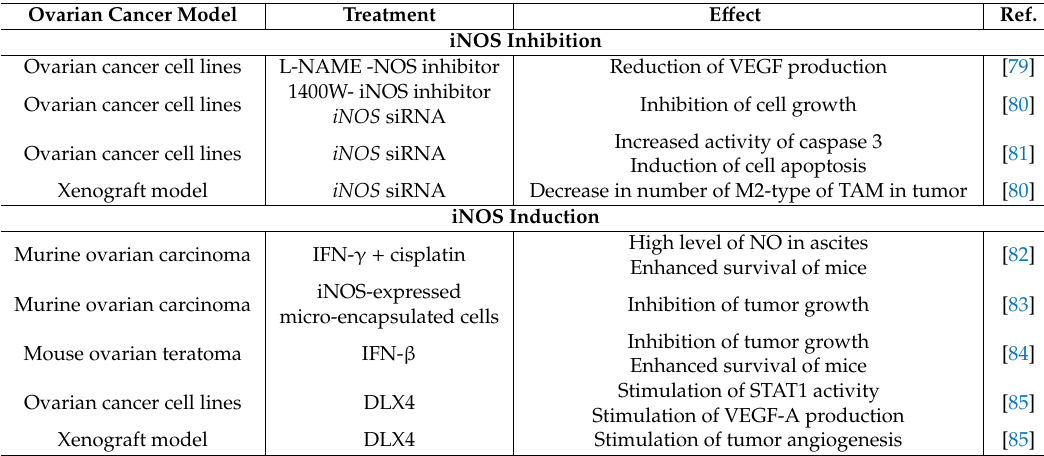
Table 3. Summary of the beneficial and detrimental e ff ects of iNOS targeting in ovarian